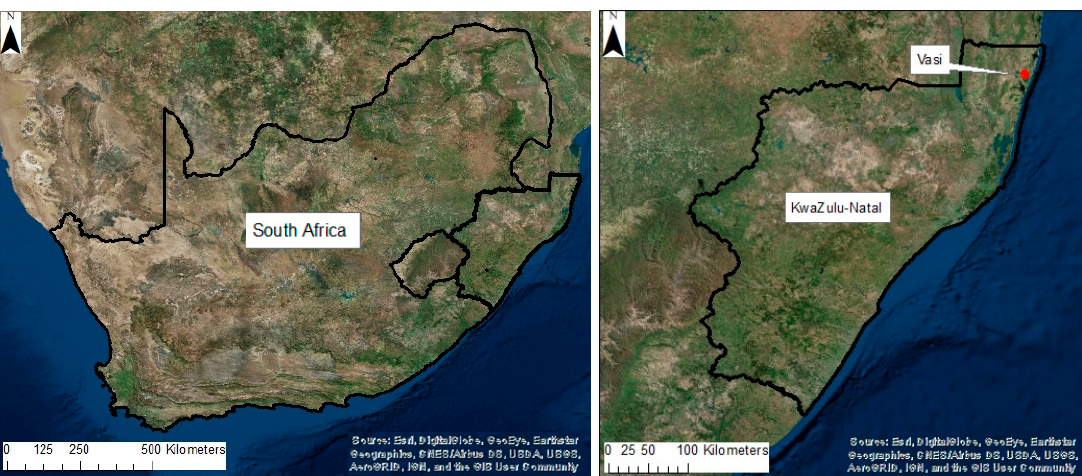
Figure 1. Vasi site within KwaZulu-Natal in South Africa.